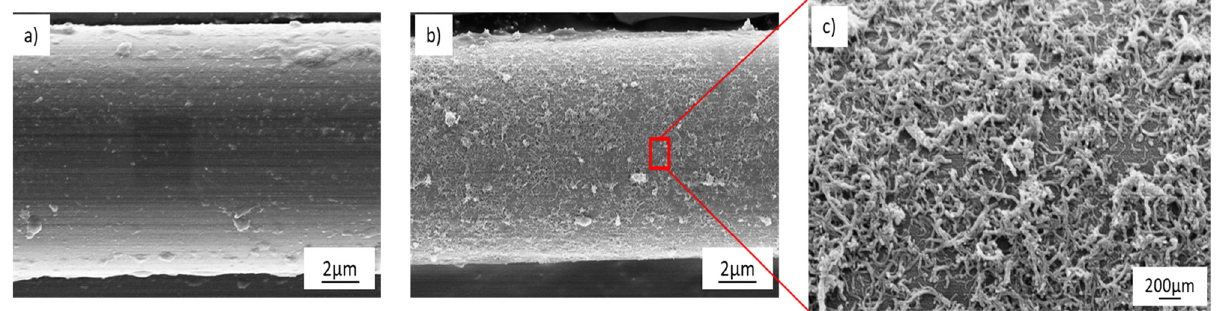
Figure 6: FESEM image of ( a ) GF, ( b ) and ( c ) hybrid CNTs - GF at 5k × and 20k × magni fi cations,